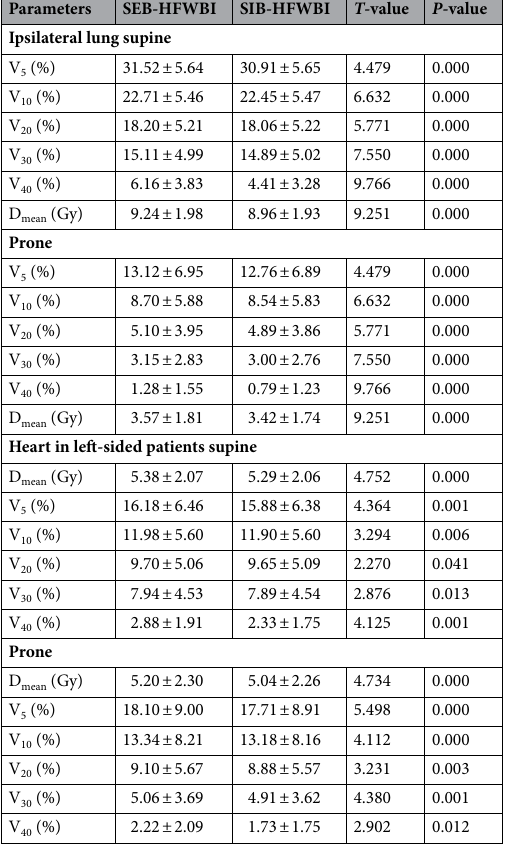
Table 4. Dosimetric evaluation of the IPSL and heart to left breast cancer patients between the SEB-HFWBI and SIB-HFWBI plans in the same position (mean). SIB simultaneous integrated boost, SEB sequential integrated boost, HFWBI hypofractionated whole-breast irradiation, V 5 the volumes that received ≥ 5 Gy, V 10 the volumes that received ≥ 10 Gy, V 20 the volumes that received ≥ 20 Gy, V 30 the volumes that received ≥ 30 Gy, V 40 the volumes that received ≥ 40 Gy, D mean the mean dose.